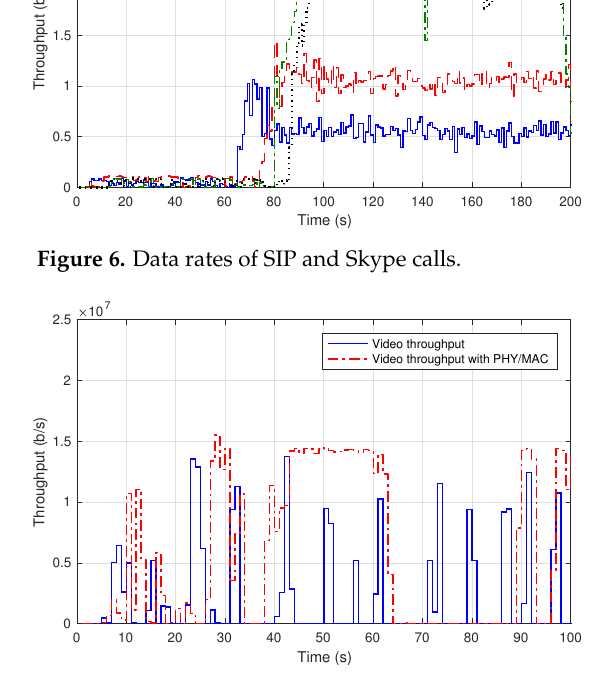
Figure 7. Data rates of video-on-demand